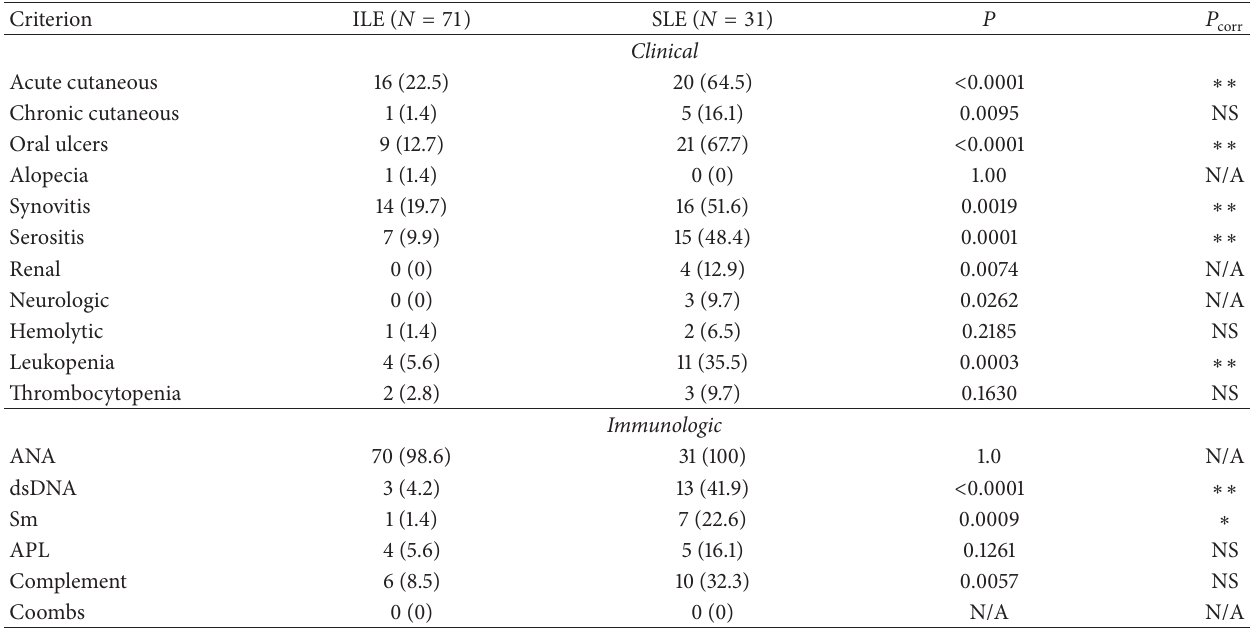
Table 3: SLICC 2012 classification criteria in ILE and SLE